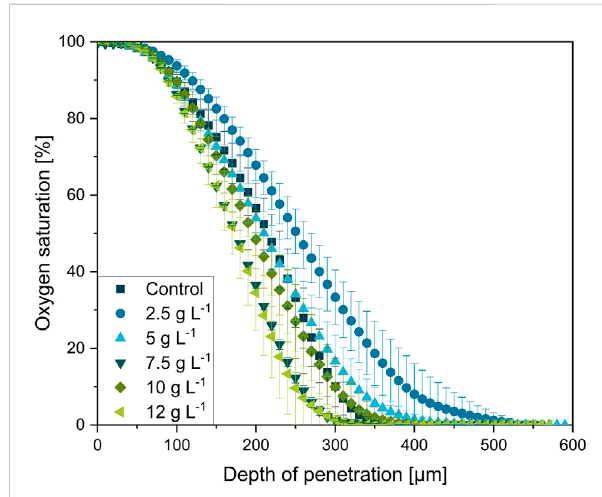
FIGURE 12 Oxygen micropro fi ling experimentally acquired with the experimental setup depicted in Figure 1. Oxygen saturation as a functionofindependanceontherelativepenetrationdepthintothe L. aerocolonigenes pellet for varying microparticle concentrations in the culture broth. Pellets were investigated after 64 h of cultivation and were selected within a similar size